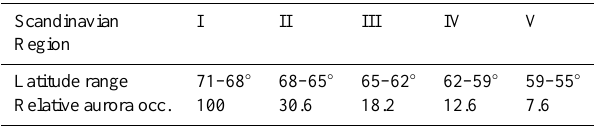
Table 1. Relative occurrence frequency of auroras vs. latitude in Scandinavia. From Tromholt